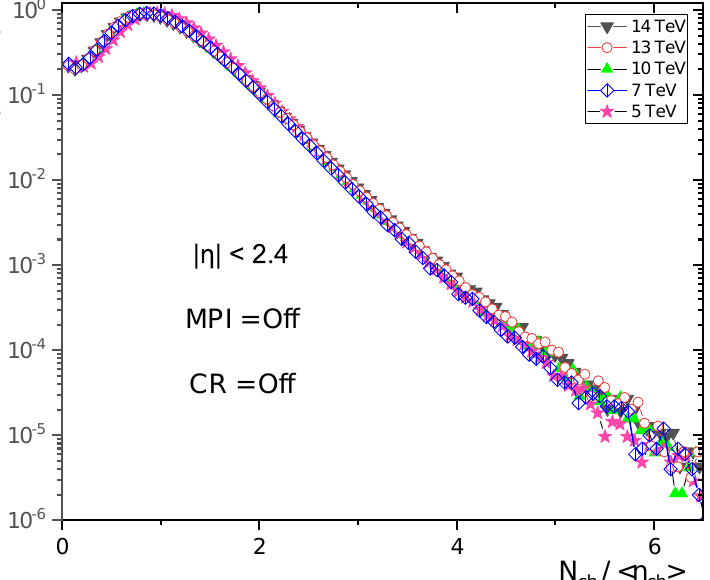
Figure 13. KNO form of charged particle multiplicity distribution at different energies in pseudora- pidity | η | < 2.4 with MPI = OFF and CR =